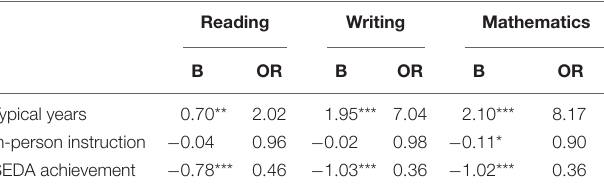
TABLE 2 | Logistic regression models predicting whether students who needed additional supports for academic skills did not receive